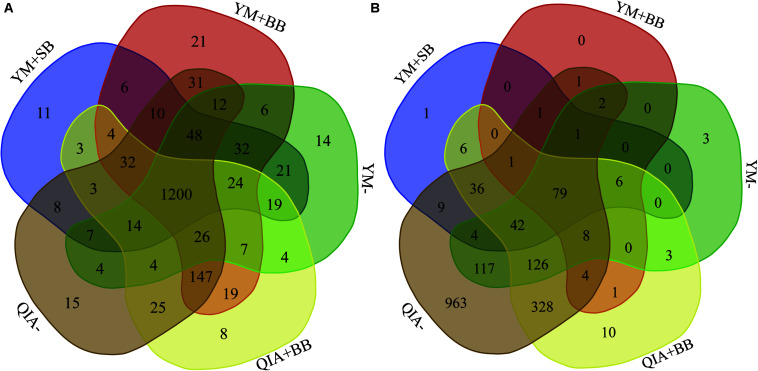
Venn diagram of bacterial (A) and protozoal (B) ZOTUs of five experimental methodologies. QIA, the chemical lysis provided by QIAamp Fast DNA Stool Mini Kit methodology; YM, the chemical lysis provided by RBB + C (Yu and Morrison, 2004); BB, bead beating; SB, sand beating; QIA–, QIA without mechanical lysis; QIA + BB, QIA with BB; YM–, YM without ML; YM + BB, QIA with BB; YM + SB, QIA with SB.